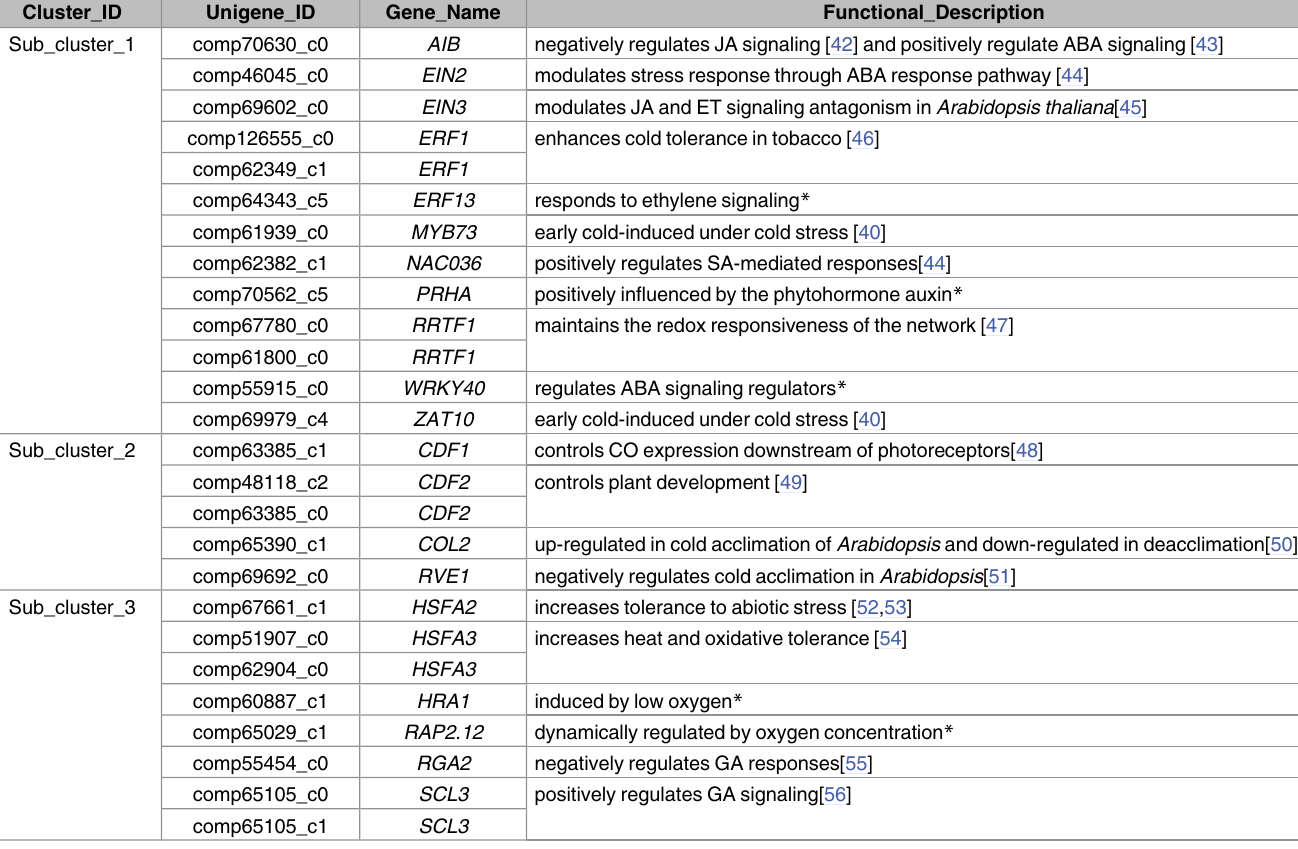
Table 1. Functions of transcription factors in protein association